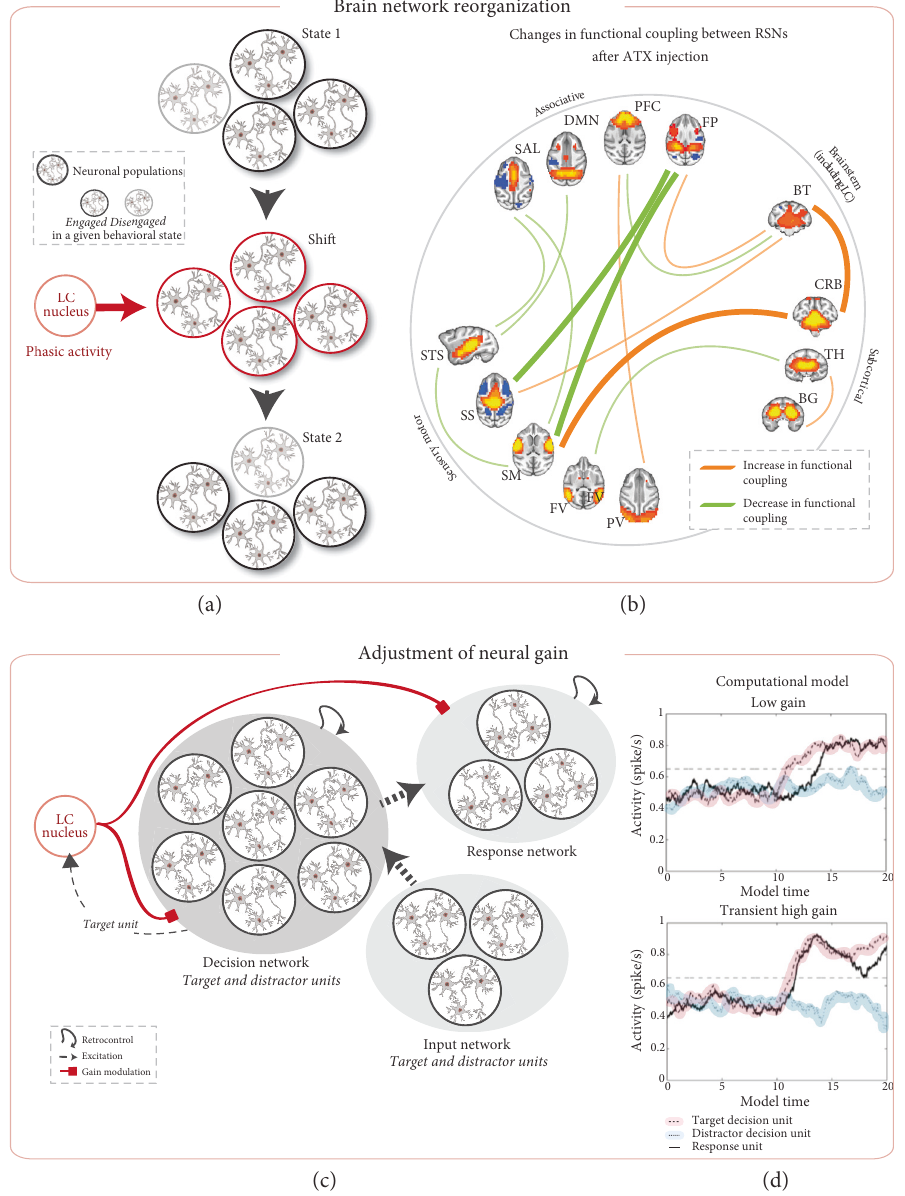
Figure 1: LC-NE system theoretical models ((a) and (b)) brain network reorganizations adapted from Bouret and Sara [33]. (a) A behavioral state is associated with a given functional network with a speci fi c spatiotemporal pattern of neuronal activity. When a stimulus induces a behavioral shift, the LC activation immediately preceding this change modulates the underlying interactions between the neuronal populations via its simultaneous action on several of its target structures, promoting changes within and between functional networks (state 1 → state 2). (b) Overview of the functional coupling changes between 13 resting-state networks (RSNs) following ATX injection (from Guedj et al. [49]). Line thicknesses re fl ect the correlation strength of the ATX-induced changes. ATX injection modulated the functional coupling of the subcortical network including the LC and decreased the functional coupling between associative and sensory- motor networks. The frontoparietal network, negatively correlated with the brainstem network including the LC region in the saline condition, switched to a positive correlation under ATX ((c) and (d)) adjustment of neural gain. (c) Architecture of the computational model described by Usher et al. [38]. The LC inputs regulate the gain via a multiplier e ff ect on the decision and the response networks. (d) Simulated time courses of activity for the response and decision model units under various neural gain levels (low and high gain). A transient increase of the neural gain induced by a LC phasic response improves the processing of the target stimulus, resulting in faster and sharper increase in response unit activity. Adapted from Usher et al. [38] and Gilzenrat et al. [60]. Circles represent a de fi ned neuronal population. The red circle represents the population of LC neurons. ATX=atomoxetine, BG=basal ganglia, BT =brainstem, CRB =cerebellum, DMN =default-mode network, FP=frontoparietal, FV=foveal visual, PFC=prefrontal cortex, PV=peripheral visual, SAL=salience, SM=somatomotor, SS=somatosensory, STS=superior temporal sulcus, and TH